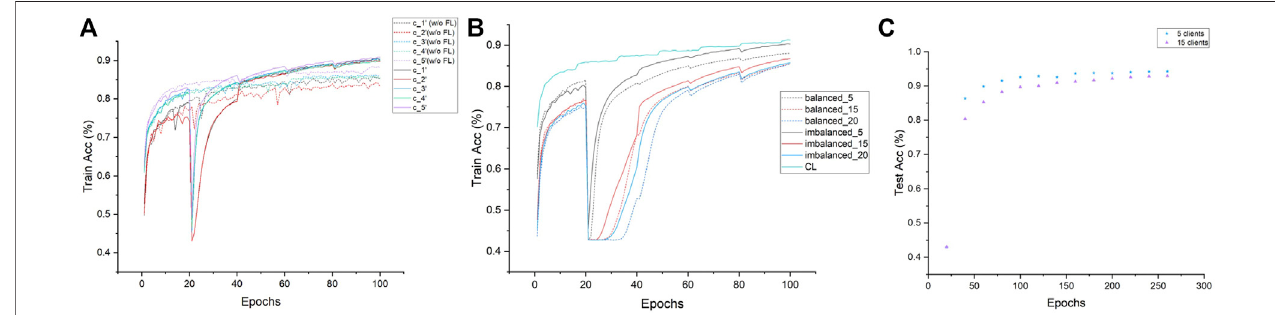
FIGURE 3 | Convergence analysis of each experiment. (A) Demonstration of the convergence of fi ve clients under imbalanced distribution within FedTSeg (solid line)andwithoutFedTSeg(dash)for100epochs. (B) DemonstrationoftheconvergenceofdifferentclientsanddistributionswithFedTSegfor100epochs. (C) Extension of the fi ve-client experiment and 15-client experiment in Table 3 , to 260